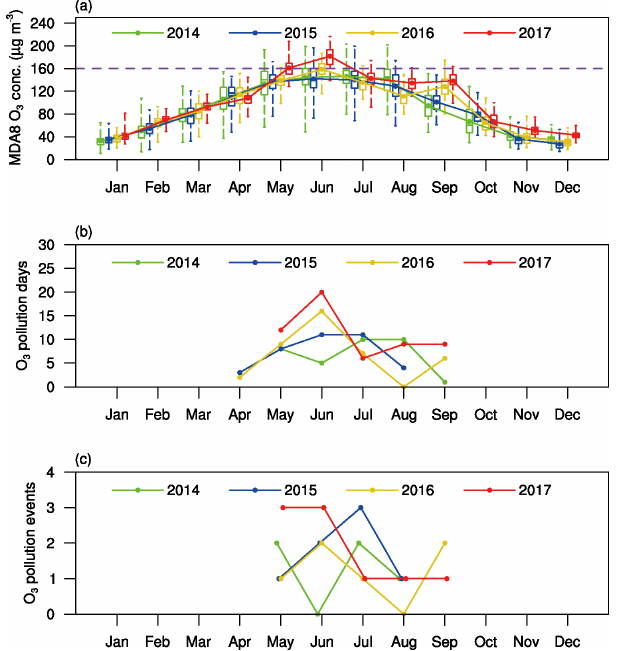
Figure 2. (a) Monthly variation in MDA8 O 3 concentration (µgm − 3 ) averaged over North China for 2014 to 2017. The boxes indicate the maximum and minimum MDA8 O 3 concentrations for 62 observational sites in North China. Dotted solid lines de- note the averaged values in North China. The dashed purple line indicates the threshold of 160µgm − 3 for O 3 -polluted days. (b) Monthly variation in O 3 -polluted days in North China for 2014– 2017. (c) Monthly variation in the number of ozone polluted events (OPEs) in North China for 2014–2017.